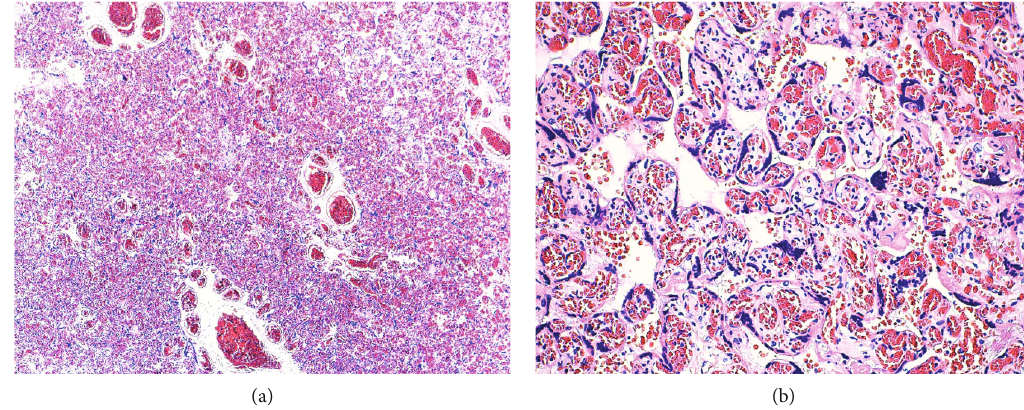
Figure 1: (a, b) Gross dissection revealed a fi rm area which measured 3 cm that histologically corresponded to a proliferation of capillary sized vessels causing expansion of contiguous a ff ected villi, composed of endothelial cells, pericytes, and myo fi broblastic stromal cells, compatible with the diagnosis of chorangioma (hematoxylin-eosin stain, original magni fi cation 4x on the left and 20x on the right).